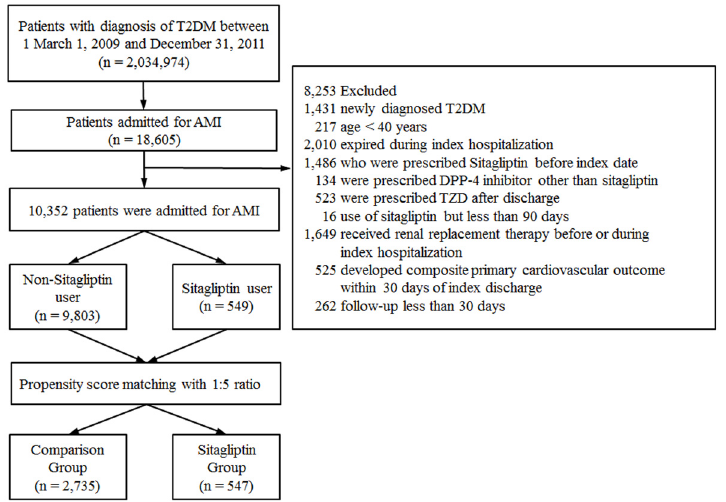
Fig 1. Flow chart of patient enrollment. T2DM patients hospitalized with a diagnosis of AMI were included in our analysis after relevant exclusions (T2DM = type 2 diabetes mellitus, AMI = acute myocardial infarction, DPP-4 = dipeptidyl peptidase 4, TZD = thiazolidinediones).